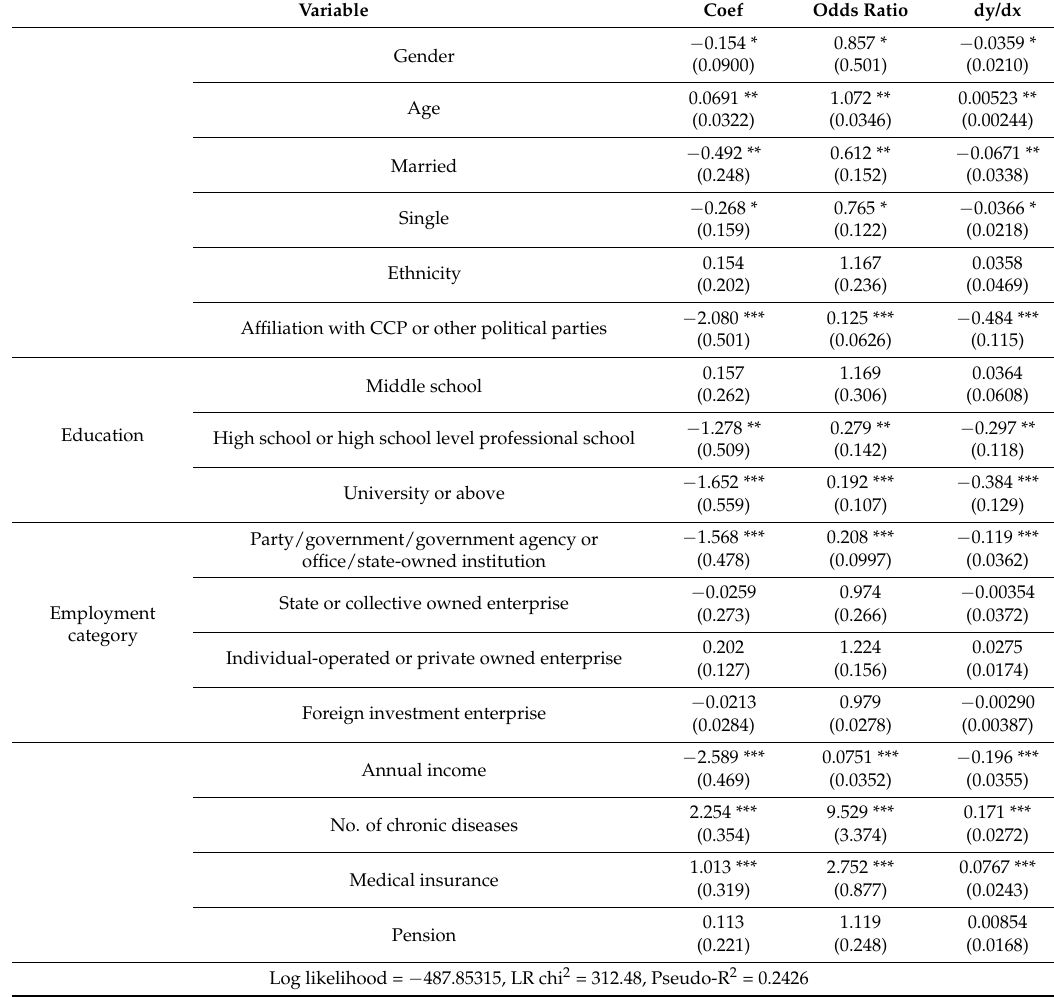
Table 4. Logistic regression results of the determinants in urban residents’ Christian